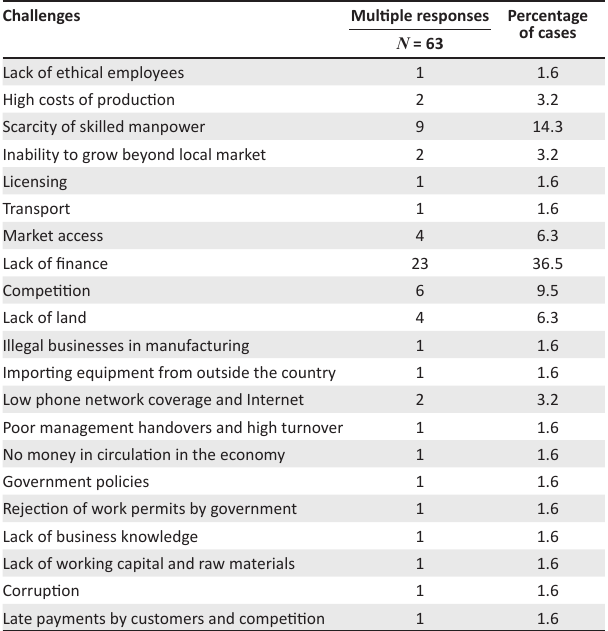
TABLE 2: Challenges faced by small, medium and micro-sized enterprises in tapping into the available business opportunities.